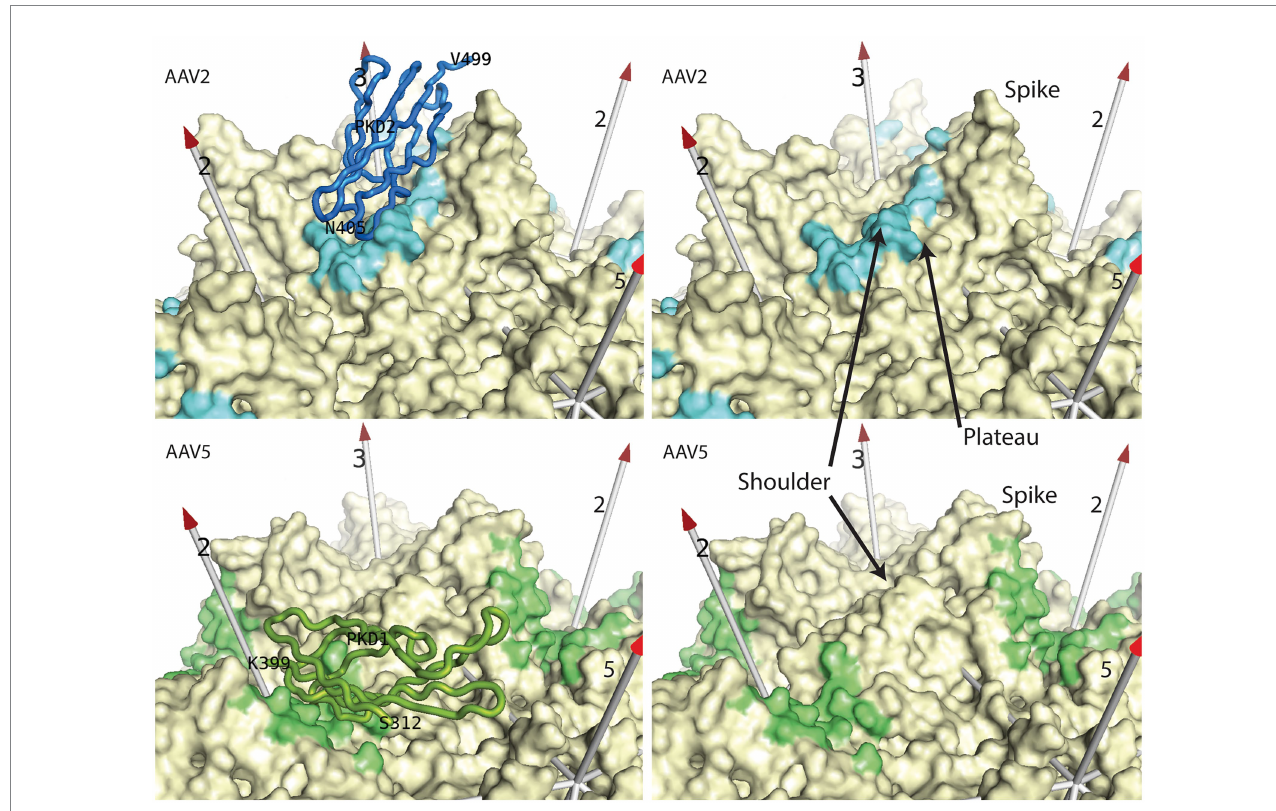
FIGURE 2 AAV receptor binding sites. Most AAV serotypes bind primarily to the PKD2 domain (blue) of AAVR as seen in the 2.4 Å cryo-EM structure of the complex (Meyer et al., 2019). A smaller clade binds to the PKD1 domain (green) as exemplified in the 2.5 Å cryo-EM structure (Silveria et al., 2020). In the right panels, the AAVR domains have been removed to reveal the contact footprints (4.5 Å cut-off) for all of the binding surfaces that are related by the viral symmetry axes (numbered arrows). Prominent features of AAV’s surface are annotated.